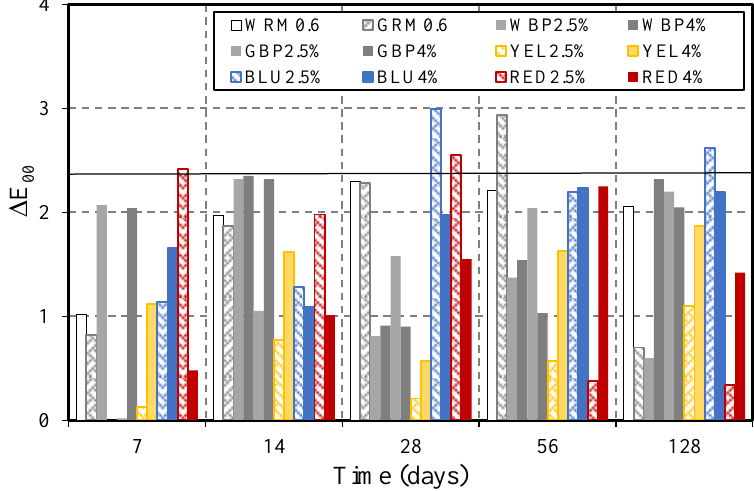
Figure 9. ΔE 00 variations of mortar series produced with cements.